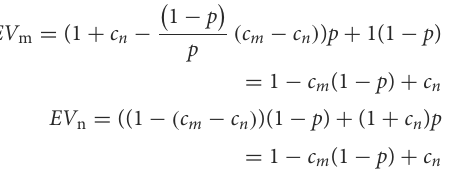
of non-migraineurs is likely to get help from